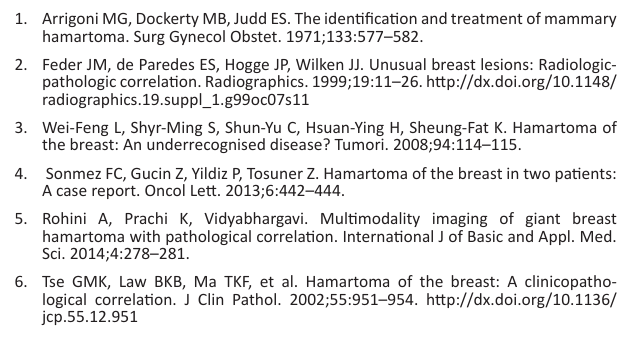
FIGURE 2: Ultrasound image at the 12 o’clock position of the right breast demonstrates a well-defined oval lesion with a mixed echogenic